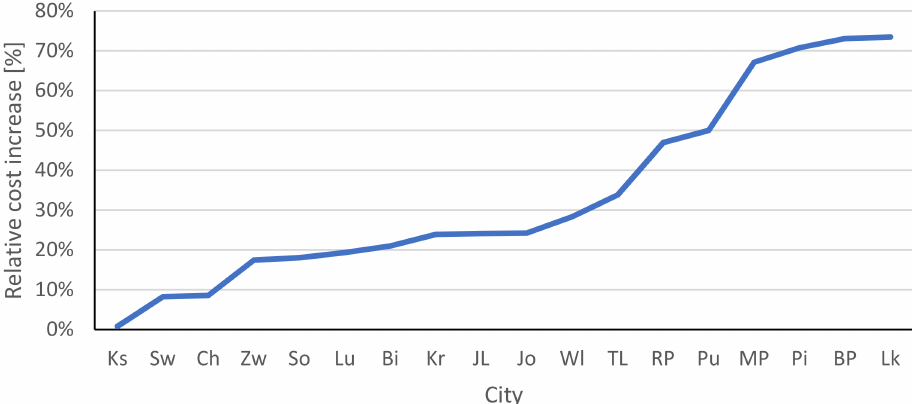
Figure 6. Relative cost increase for original locations in comparison with the optimal one.